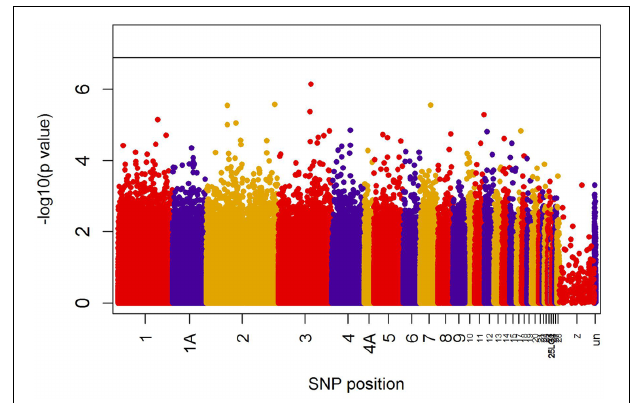
FIGURE 2 | Significances (shown as –log10) of all SNPs included in the genome-wide association analyses of egg-laying date testing for an interaction between temperature and SNP effects on laying date. The black line indicates the genome-wide significance level equivalent to P = 0.05 after applying a Bonferroni correction. Points are color-coded by chromosome.